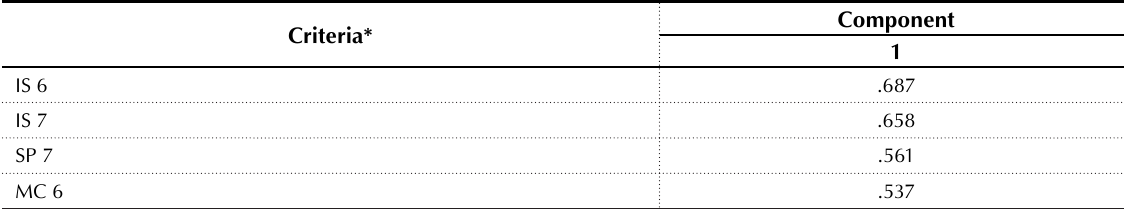
Table 7. Rotated Component Matrix: Sub-factors extracted from Factor 2